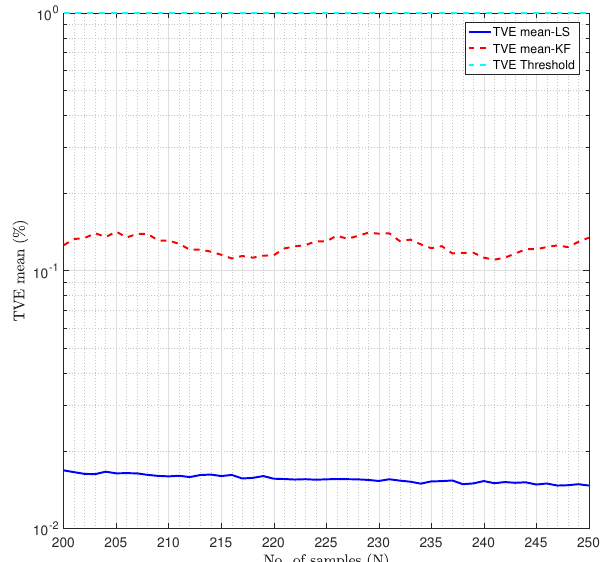
Figure 2. Mean total vector error ( TVE ) versus number of